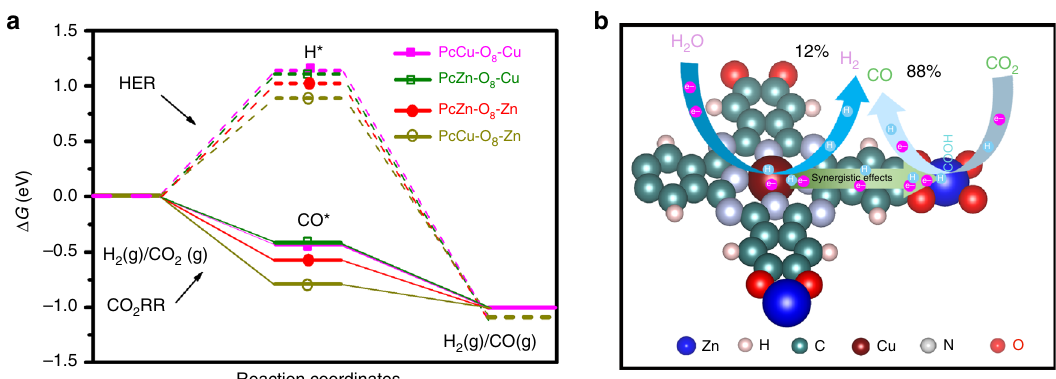
Fig. 5 Reaction mechanism analysis. a Free energy pro fi les for HER (dashed lines) and CO 2 RR (solid lines) on M1O 4 complexes of PcCu-O 8 -Zn at U = 0.55 V. b Schematic HER and CO 2 RR reaction process of PcCu-O 8